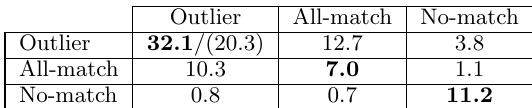
Table 7: Crowdsourced evaluation of T-patterns, FSM and FPM (i.e., user